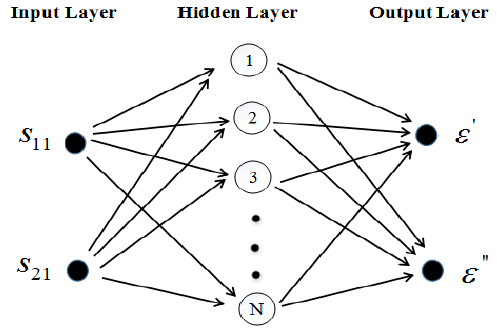
Figure 3. Schematic architecture of neural network.